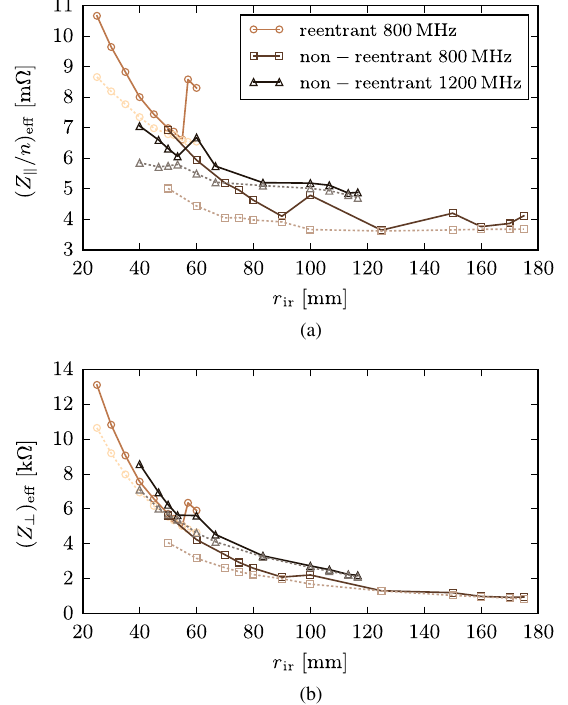
FIG. 9. Effective longitudinal (a) and transverse (b) impedance accumulated over the number of required cavities to satisfy the conditions in Table I. In solid, the number of cavities is rounded up. In dashed, the number of cavities is not rounded providing smoother relation that shows a shallow minimum at r ¼ 125 mm for the longitudinal impedance. ir